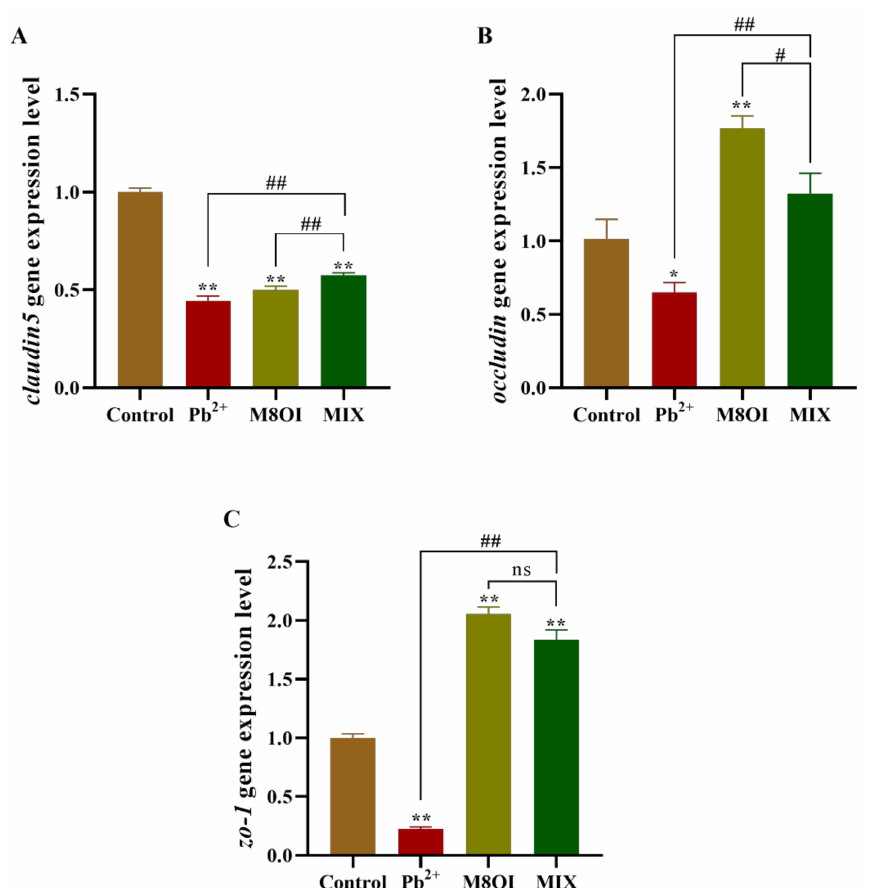
Figure 5. Effects of the combined exposure to Pb 2+ and the ionic liquid M8OI on the expression of tight junction code gene in blood–brain barrier of fish brain. ( A ) claudin5 . ( B ) occludin . ( C ) zo-1 . Data are represented as mean ± SEM. * p < 0.05 and ** p < 0.01 are expressing the difference levels between control and exposure groups. # p < 0.05, and ## p < 0.01 are expressing the difference levels of between co-exposure and single exposure groups, and “ns” represents not